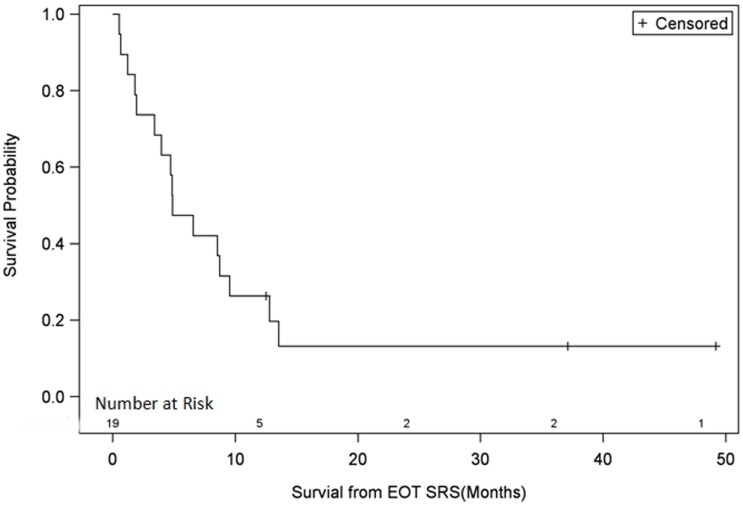
Survival plot for all patients. EOT SRS, end of treatment with stereotactic radiosurgery.